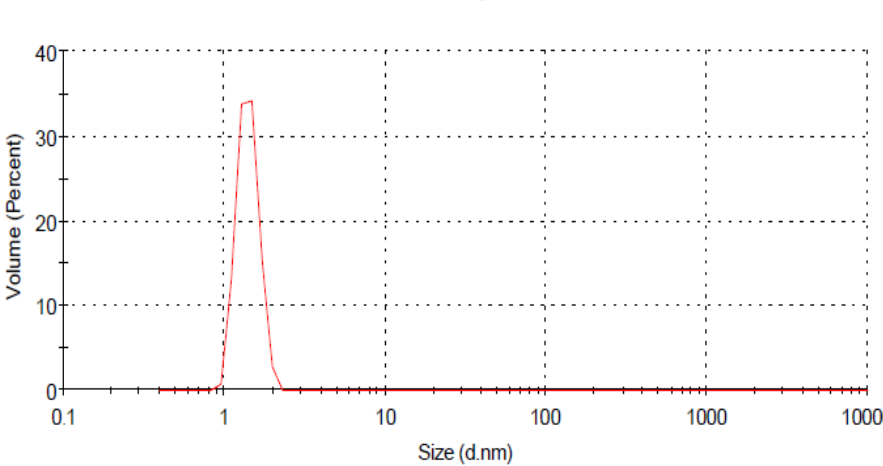
Figure 4. Z average size of Glycyrrhizic acid nanoparticles.